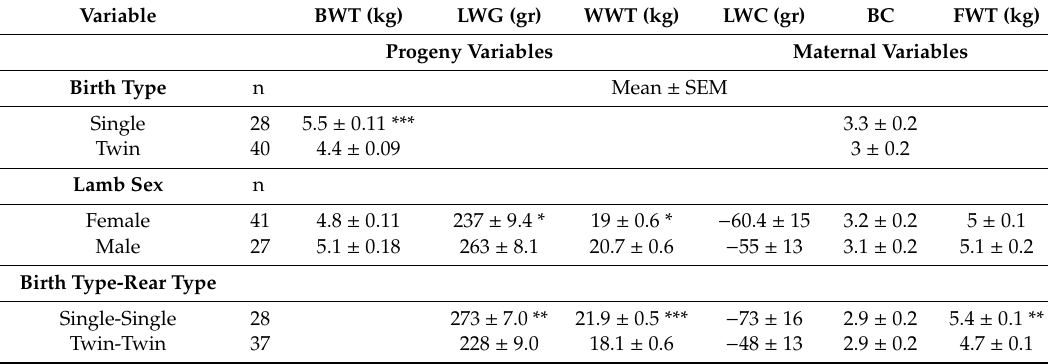
Table 2. Live weight change (LWC), body condition (BC), and wool weight (FWT) in Rambouillet ewes during lactation in Experiment 2. Growth of their lambs from birth (birth weight (BWT)) to weaning (weaning weight (WWT)), allowing measurement of live weight gain (LWG), in lambs born and raised as singles (1-1), born and raised as twins (2-2), or born as female or male. Values are represented by mean ±